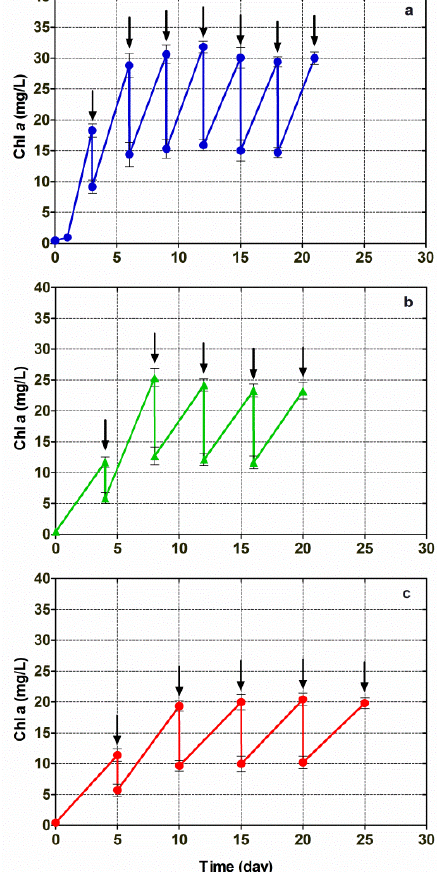
Figure 4. Changes in the Chl-a concentration versus time, in Chlorella vulgaris CCALA 896 grown under three different repetitive batch-growth ( i.e. , semi-continuous) regimens and using a modified Kolkwitz medium. The Chlorella cultures were diluted by removing half of the reactor working volume: ( a ) every 3 days (nominal dilution rate = 0.167 day −1 ); ( b ) every 4 days (nominal dilution rate = 0.125 day −1 ) and ( c ) every 5 days (nominal dilution rate = 0.100 day −1 ). Arrows indicate when the dilutions were